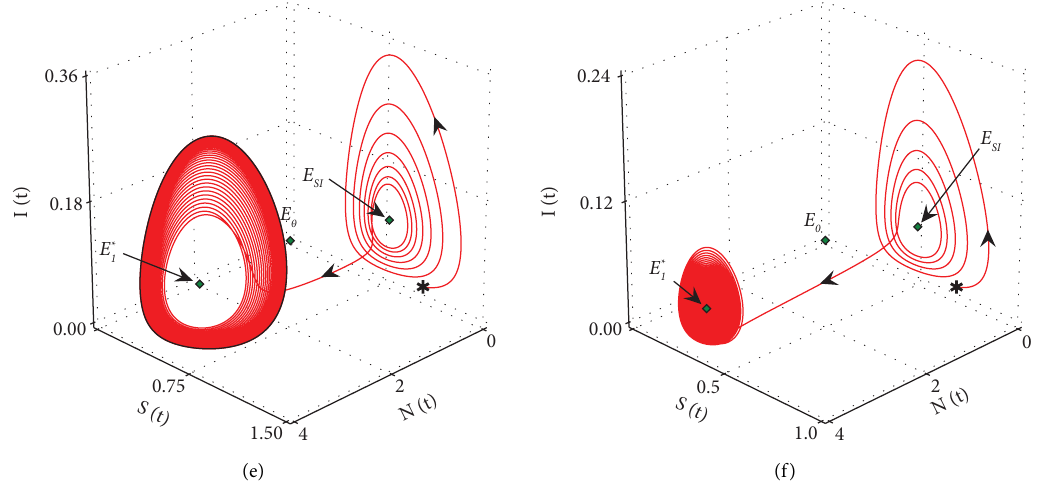
Figure 2: Phase portrait of system (4) with parameter values (26) and α � 0 . 952. (a) β � 0 . 01, (b) β � 0 . 05, (c) β � 0 . 14, (d) β � 0 . 20, (e) β � 0 . 25, and (f) β � 0 . simultaneously after β across the critical value β ∗ ≈ 0 . 1377 2 via saddle-node bifurcation. Notice that for the set of pa- rameters and β ∗ < β < β ∗ , the stability conditions of E SI and 2 3 E ∗ � ( 2 . 31322 , 1 . 42857 , 0 . 26803 ) 1